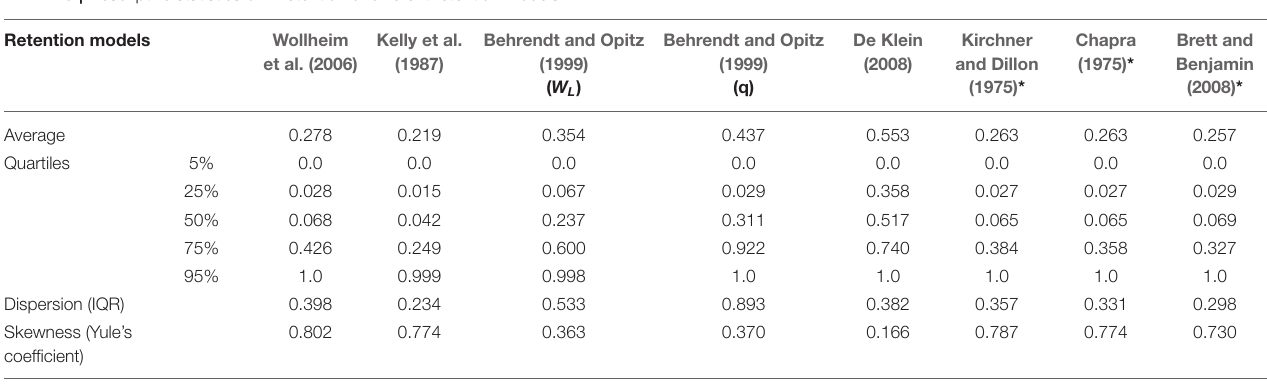
TABLE 5 | Descriptive statistics of P retention of different retention models. Retention